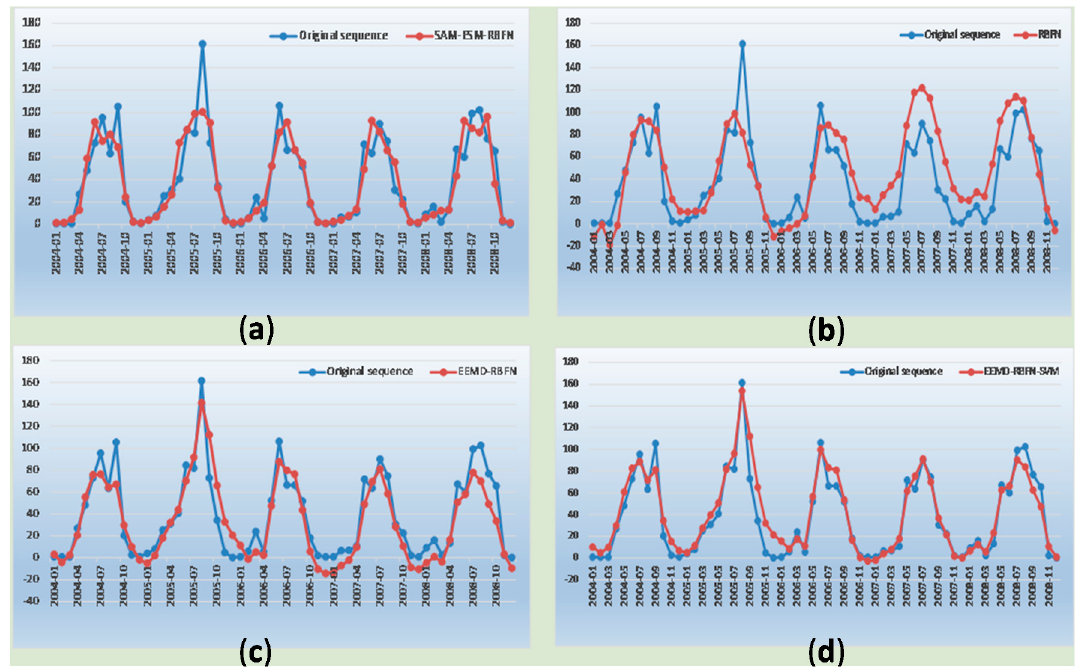
Figure 9. Single model forecast effect chart. ( a ) The result of the SAM–ESM–RBFN model; ( b ) The result of RBFN; ( c ) The result of the EEMD–RBFN model; ( d ) The result of the EEMD–RBFN–SVM model.